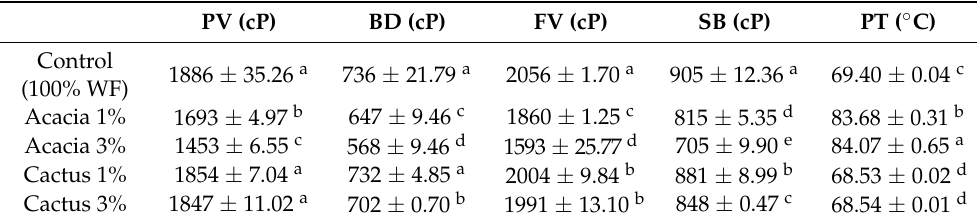
Cactus 3% 1847 ± 11.02 a 702 ± 0.70 b 1991 ± 13.10 b 848 ± 0.47 c 68.54 ± 0.01